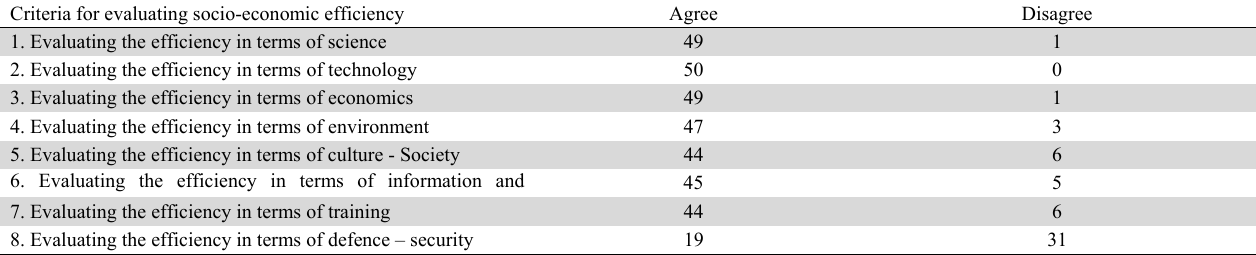
Survey results on criteria for evaluating socio-economic efficiency of topics/projects Criteria for evaluating socio-economic efficiency Agree